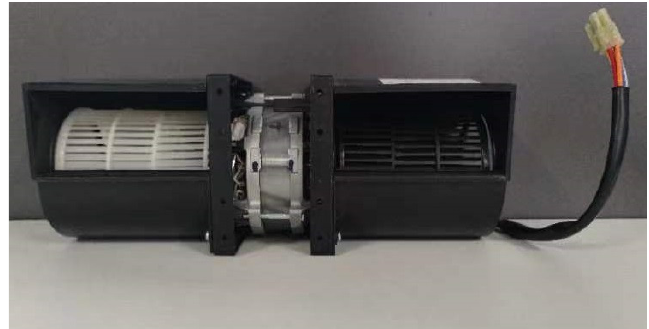
Figure 3. The prototype squirrel cage fan used in performance